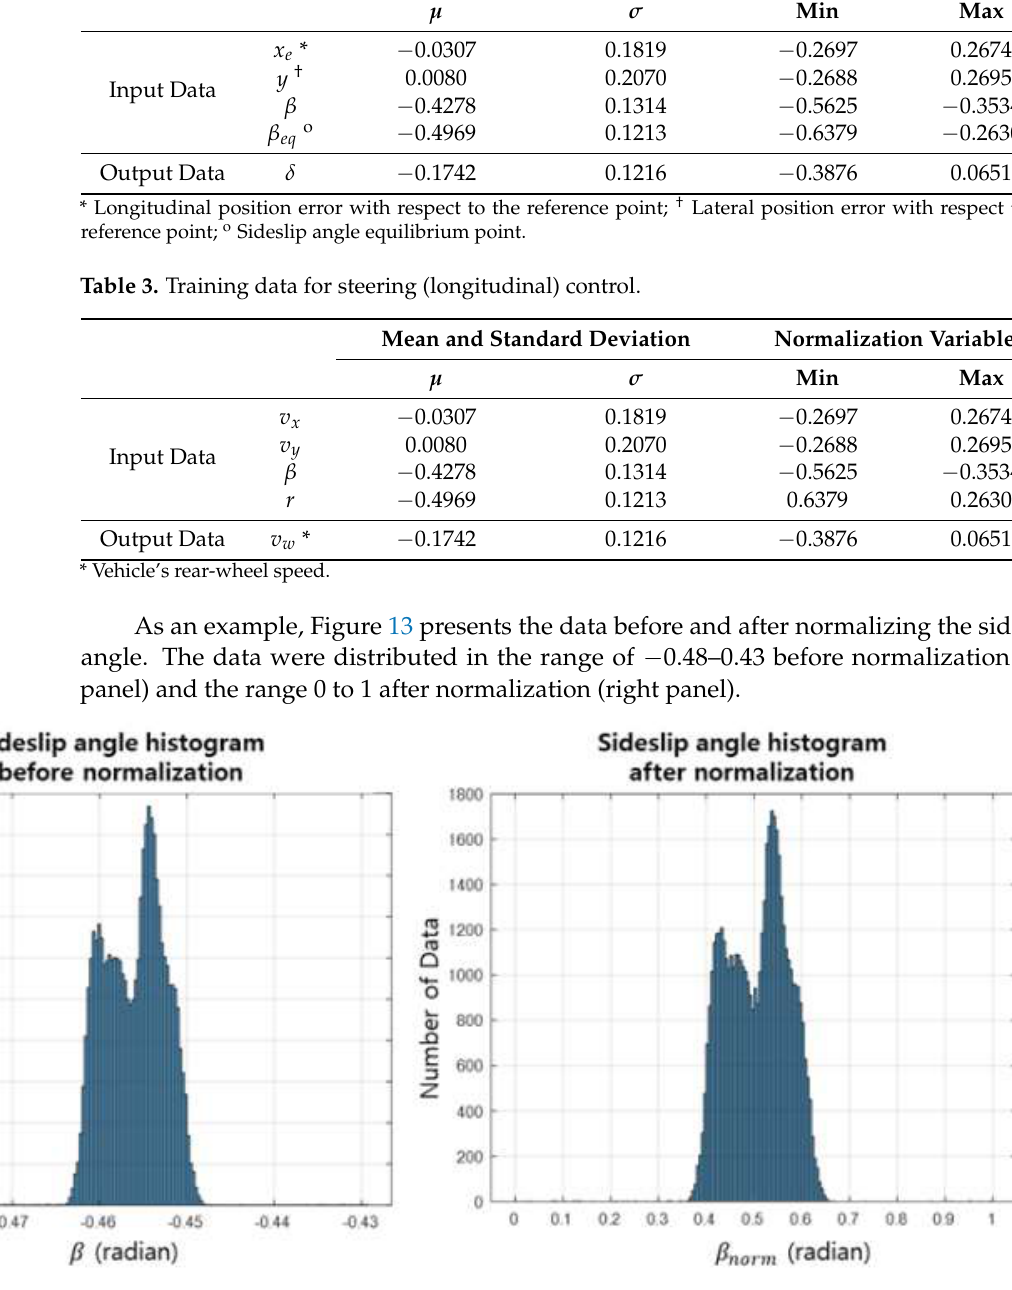
Table 2. Training data for steering (lateral) control. Mean and Standard Deviation Normalization Variables